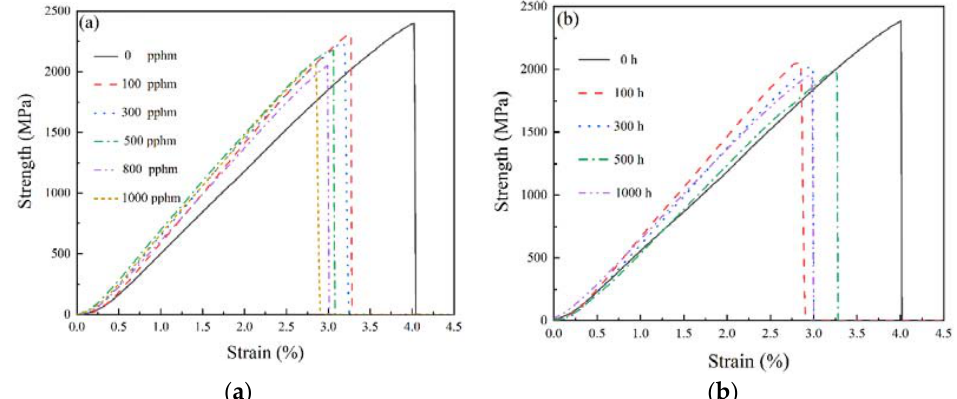
Figure 5. Stress–strain relationship of Kevlar fiber in ozone environment: ( a ) When the exposure time of ozone was 100 h, different ozone concentrations, ( b ) When the ozone concentration was 1000 pphm, different ozone exposure times.